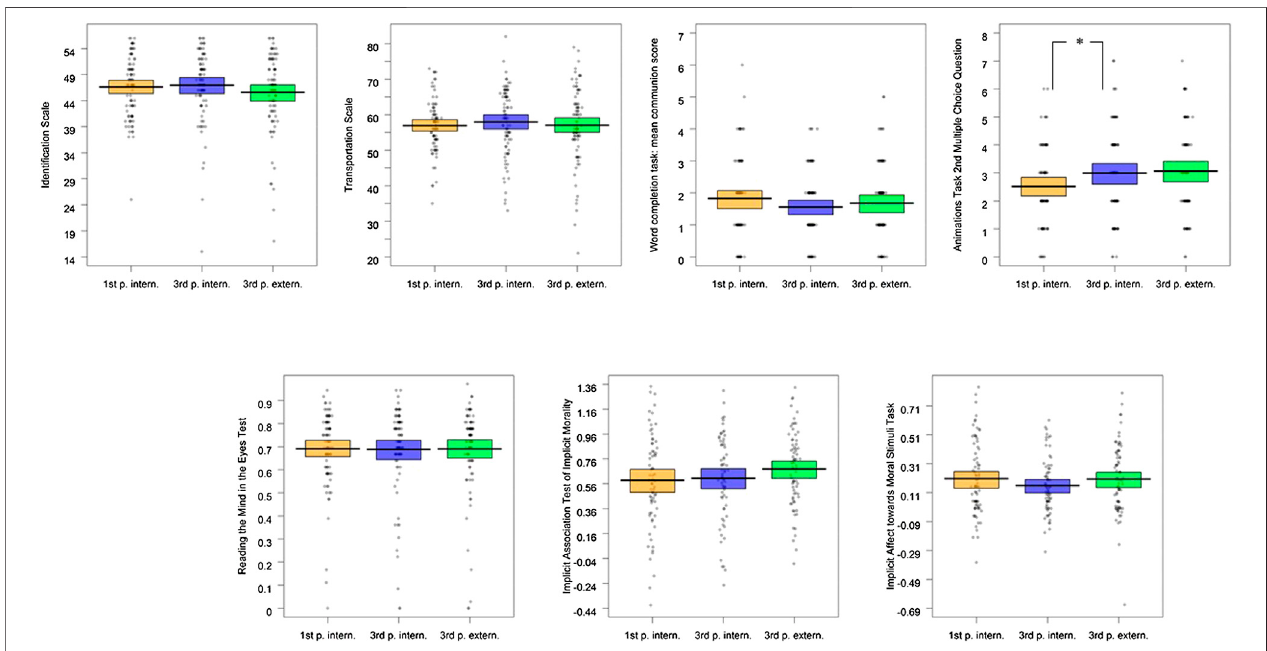
FIGURE 5 | Pirate plots for main outcomes variables of Experiment